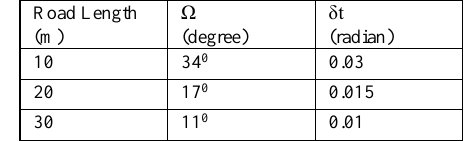
Table 1: Different parameters used in the three test cases of input data dimensions analysis.